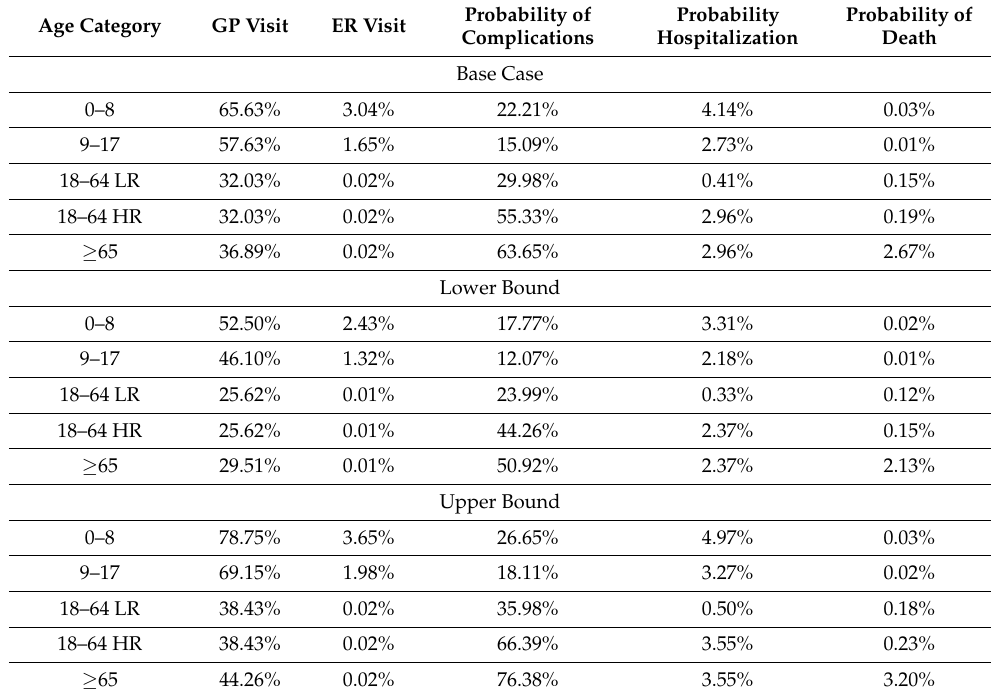
Table A6. Lower and upper bounds for probabilities of clinical events in